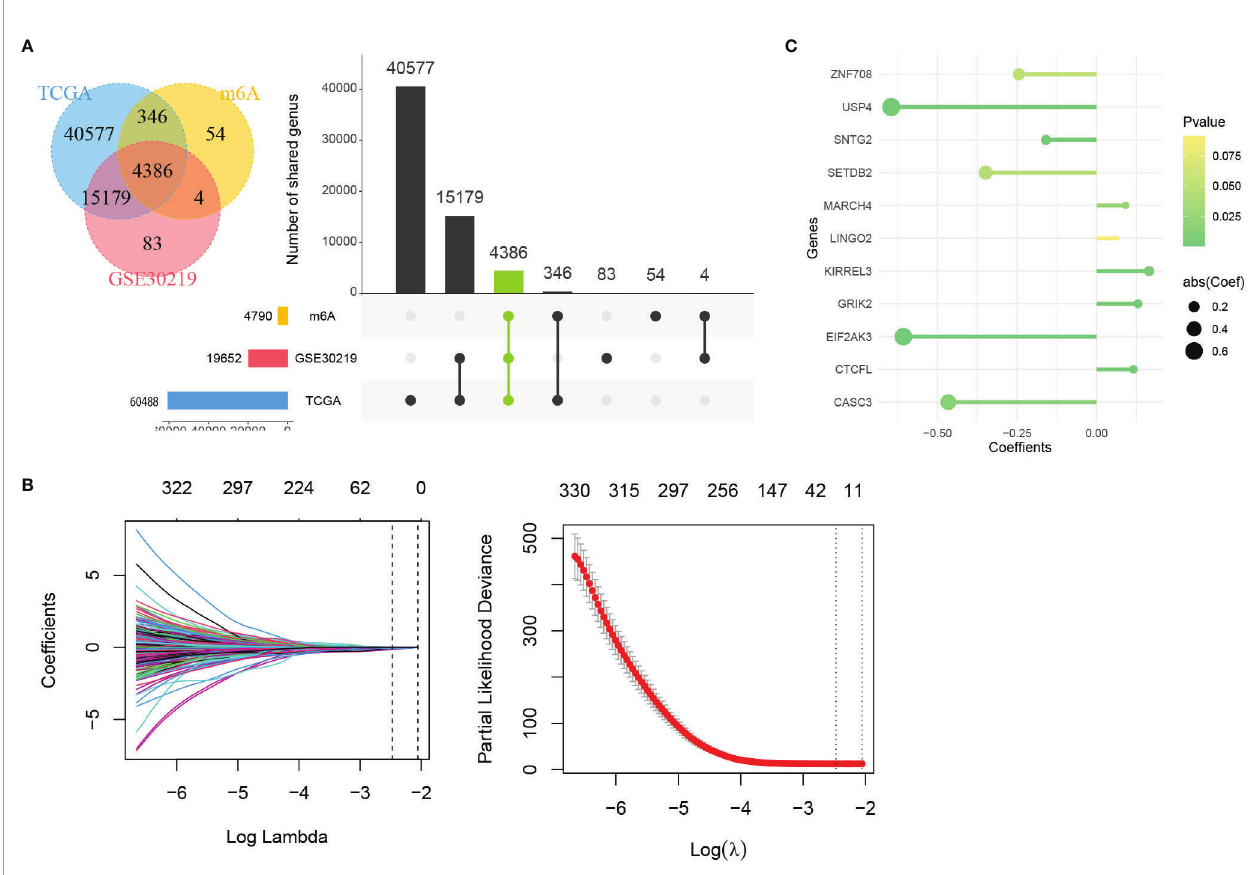
FIGURE 3 | Identi fi cation of genes in mRNA model. (A) Venn plot of 4386 mRNAs related to m 6 A. (B) LASSO shrinking path diagram. (C) The coef fi cients of 11 genes in the